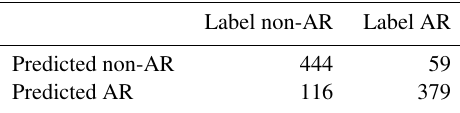
Table B4. Confusion matrix of the method for the testing set – the CAM5.1 data (daily, 25km). It shows the number of correctly recognized (the diagonal) and the number of incorrectly classified events (off-diagonal).